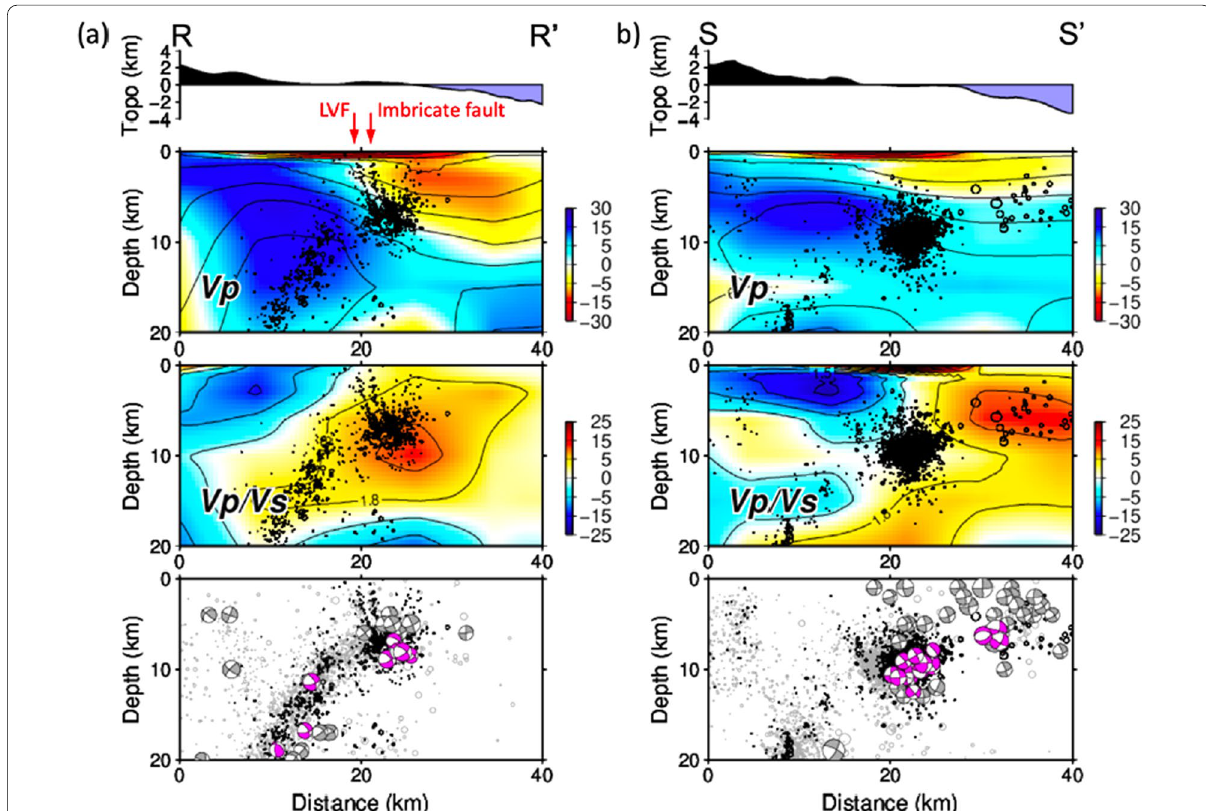
Fig. 8 Enlarged profile R–R ′ and S–S ′ across a the northernmost LVF and b the Milun fault area, respectively. See maintext for detailed discussion. The gray circles and gray beachballs are the relocated hypocenter of background seismicity and focal mechanisms from AutoBATS (Jian et al. 2018). The black circles and purple beachballs are the relocated hypocenter and redetermined first‑motion focal mechanism of the 28 earthquake clusters. The profile location is shown in Fig.